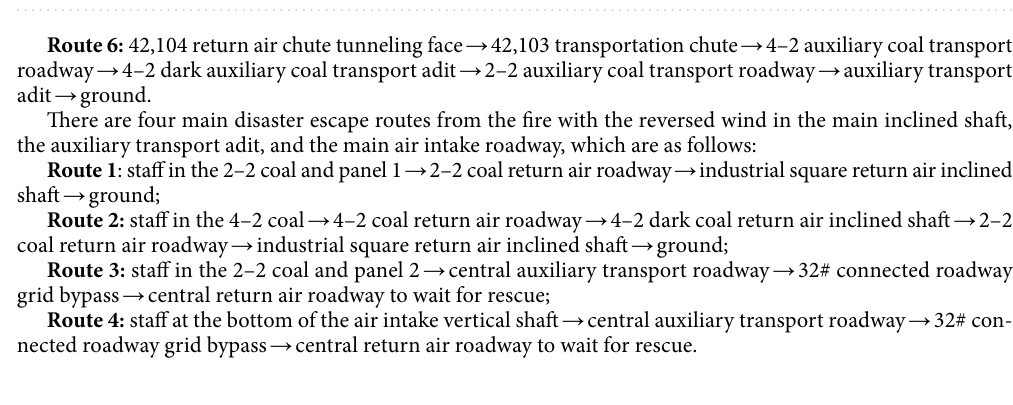
Figure 4. Schematic diagram of the ventilation network of the Burtai coal